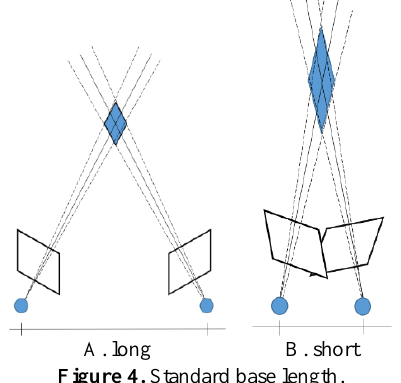
Figure 4. Standard base